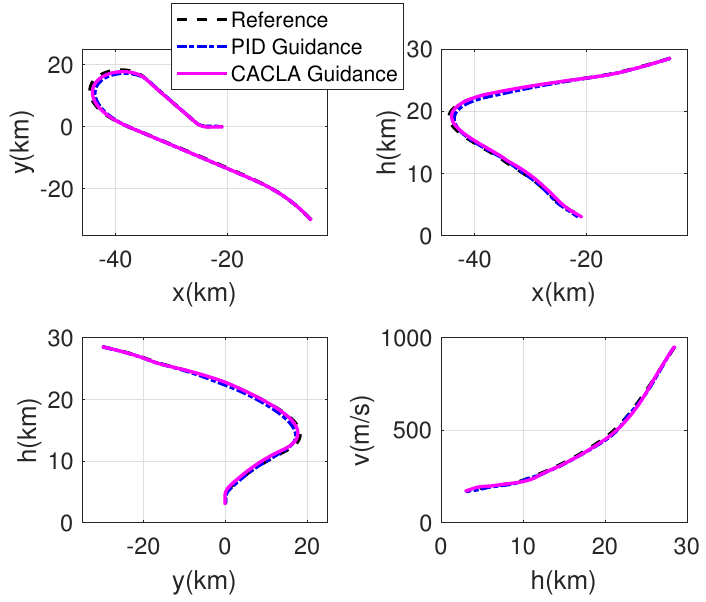
Figure 8. Three views of the TAEM trajectories and the velocity profiles with respect to altitude in comparison simulation.